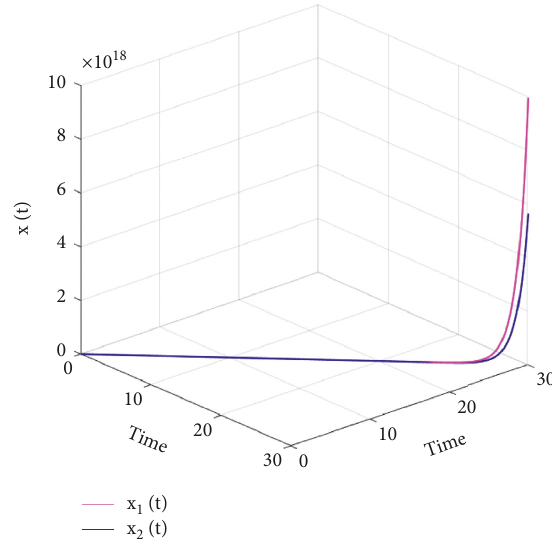
Figure 8: State responses of the original system without